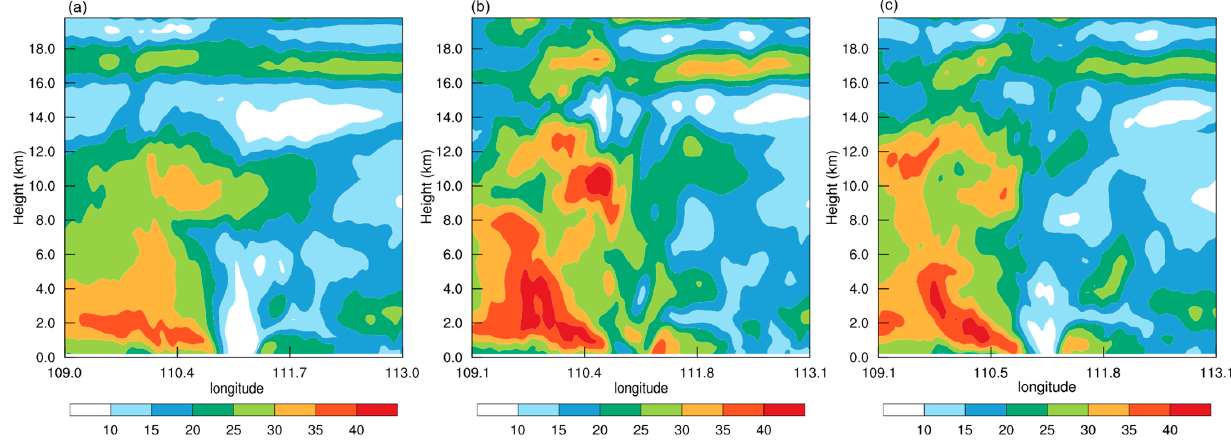
Figure 9. Vertical cross sections of horizontal wind speed with units as m s − 1 . ( a ) CTRL; ( b ) DA_ ψχ ; ( c ) DA_UV.